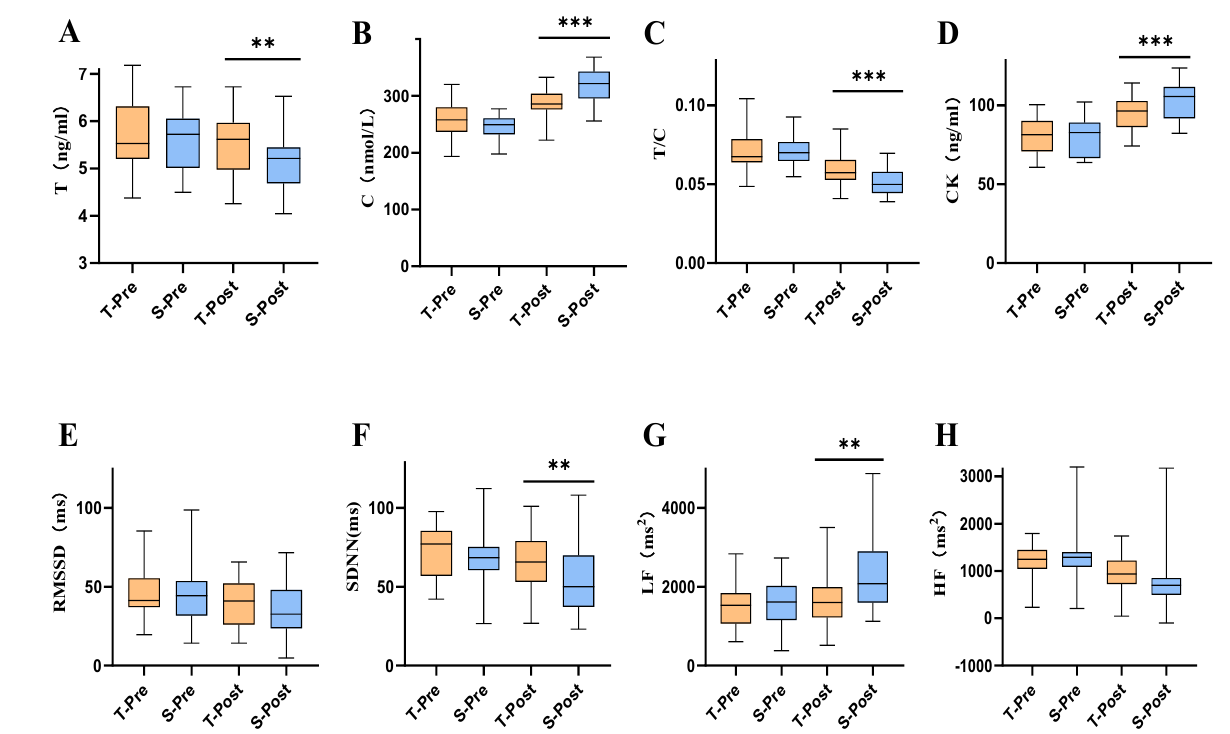
Figure 2. Effects of tPCS intervention programs on indicators of blood markers and HVR after medium − intensity training. Note: ( A ): Effects of tPCS intervention on T; ( B ): Effects of tPCS intervention on C; ( C ): Effects of tPCS intervention on T/C; ( D ): Effects of tPCS intervention on CK; ( E ): Effects of tPCS intervention on RMSSD; ( F ): Effects of tPCS intervention on SDNN; ( G ): Effects of tPCS intervention on LF; ( H ): Effects of tPCS intervention on HF. ** represents p < 0.05; *** represents p < 0.01; Orange ( (cid:110) ) means experimental group; Blue ( (cid:110) ) means control group (the same below). T − pre means before true intervention; S − pre means before sham intervention; T − post means after true intervention; S − post means after sham intervention.